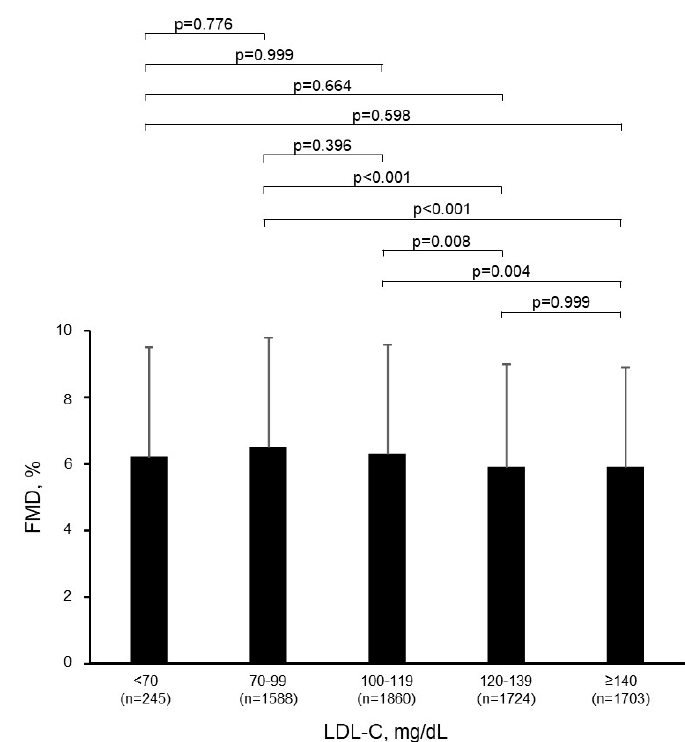
Figure 2. Comparison of FMD values of each group. Bar graphs show flow-mediated vasodilation (FMD) in low-density lipoprotein cholesterol (LDL-C) < 70 mg/dL, 70 − 99 mg/dL, 100 − 119 mg/dL, 120 − 139 mgdL, and ≥ 140 mg/dL groups. The error bars indicate the standard deviation. Table 2. Multiple linear regression analysis of the relationships between FMD and variables.